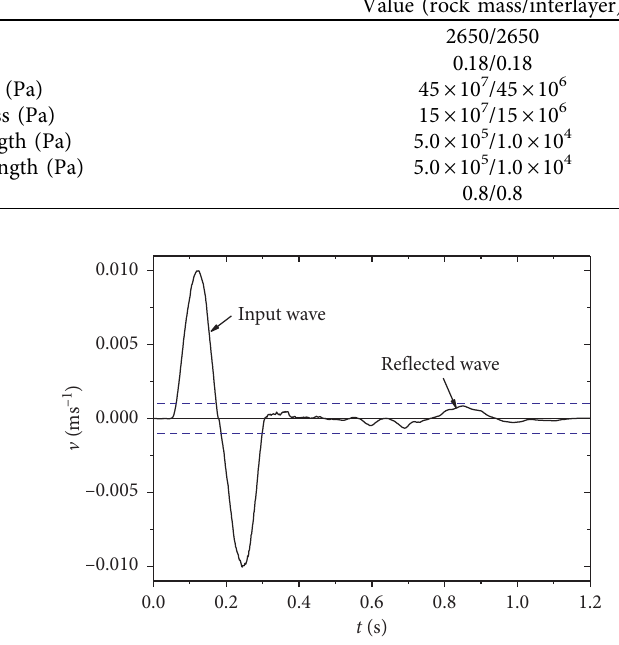
Figure 18: Absorption effect of the boundary.